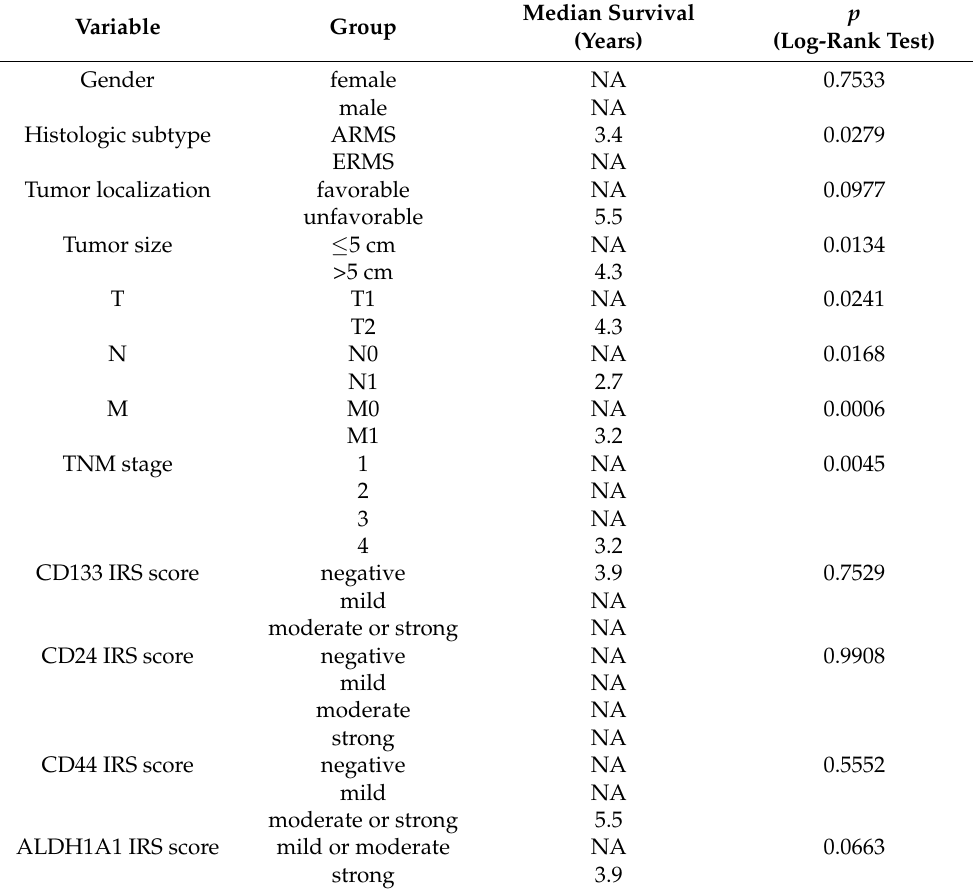
Table 4. Overall survival prognostic factors.